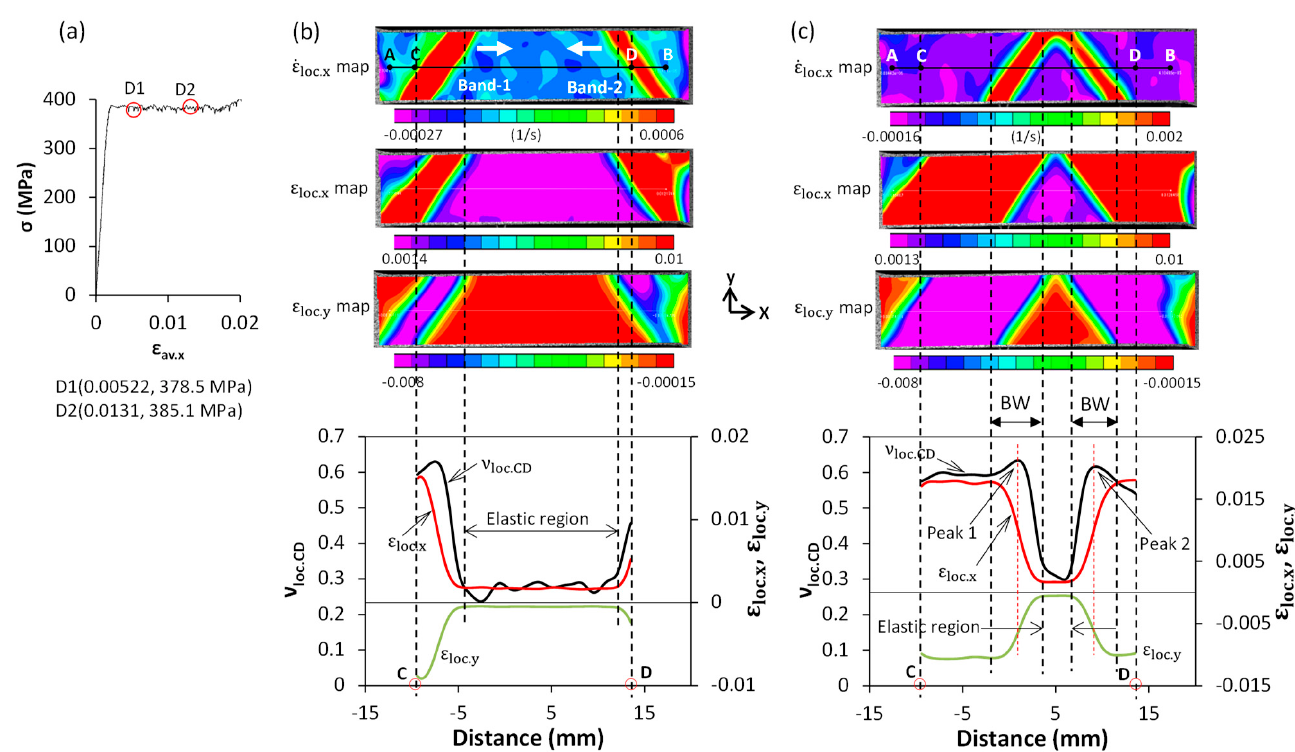
Figure 9. ( a ) Two points of interest (D1, D2) on the stress–strain curve in Phase 2. ( b , c ) Maps of the local strain rate along the x-axis ( ε . loc.x ), the longitudinal local strain ( ε loc.x ), and the transversal local strain ( ε loc.y ). The ε loc.x , ε loc.y , and ν loc.CD data were extracted along the CD line from the corresponding maps; (b,c) correspond to points D1 and D2, respectively. BW,